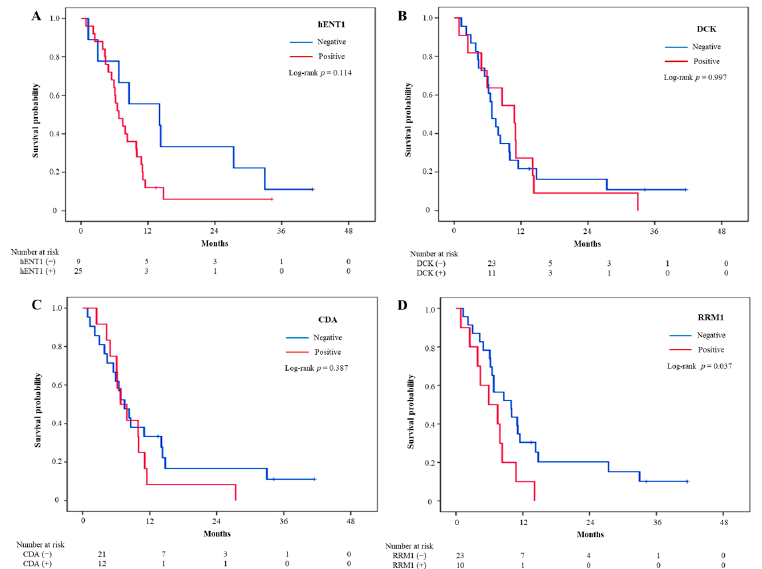
Figure 3. Kaplan–Meier analysis of the relationships of intratumoral expression of biomarkers with overall survival in patients with biliary tract cancers. ( A ) hENT1, ( B ) DCK, ( C ) CDA, ( D ) RRM1. hENT1, human equilibrative nucleoside transporter 1; DCK, deoxycytidine kinase; CDA, Cytidine deaminase; RRM1, ribonucleotide reductase subunit